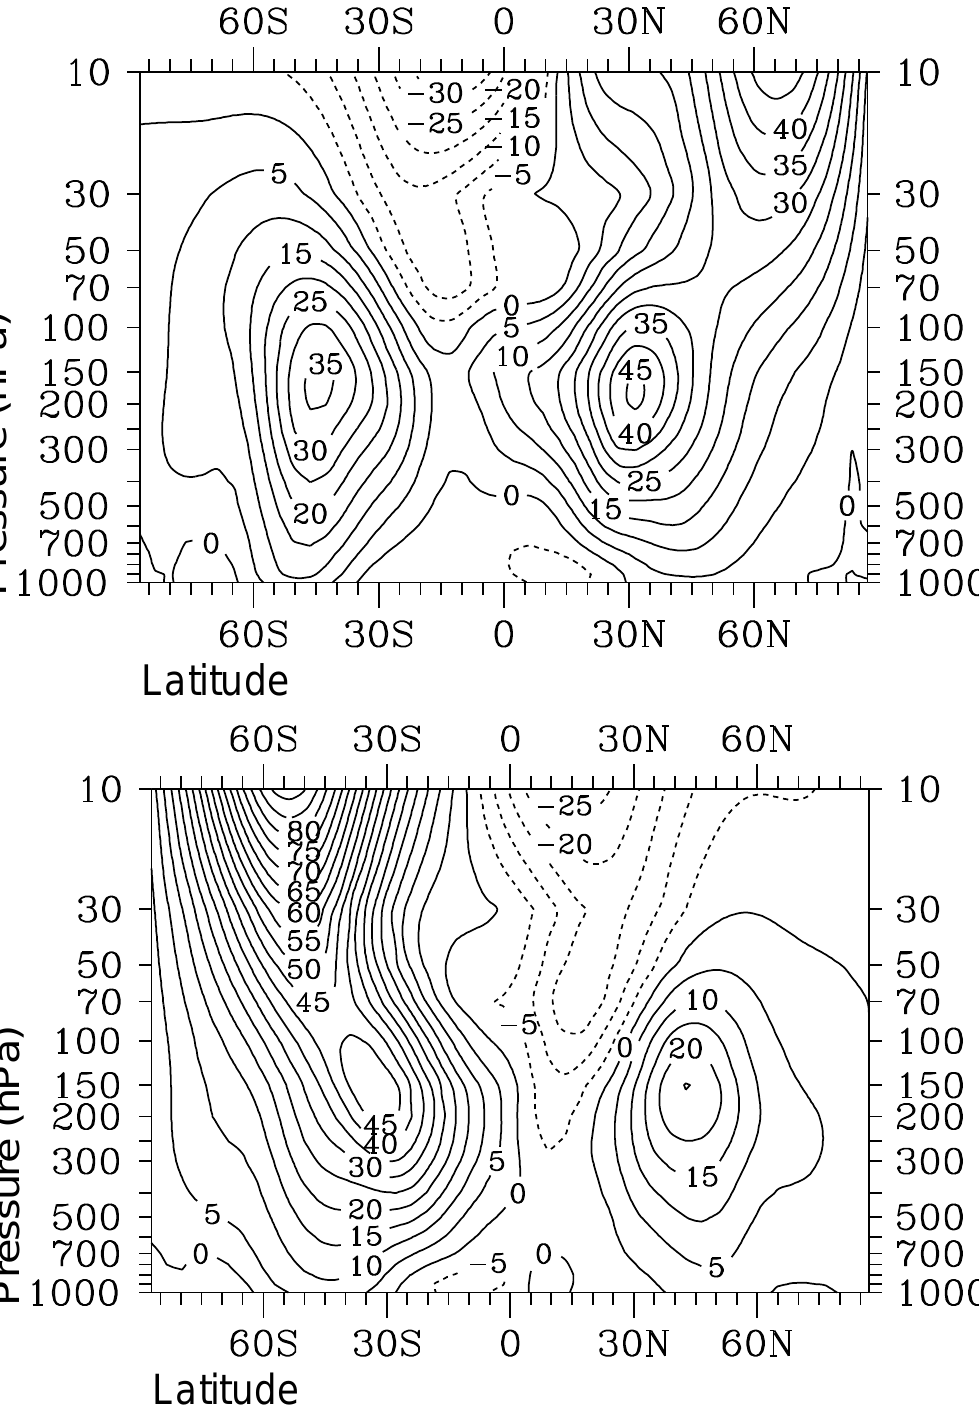
Fig. 2. Climatological zonal mean wind fields for January (top) and July (bottom), based on the 20-year model simulation.